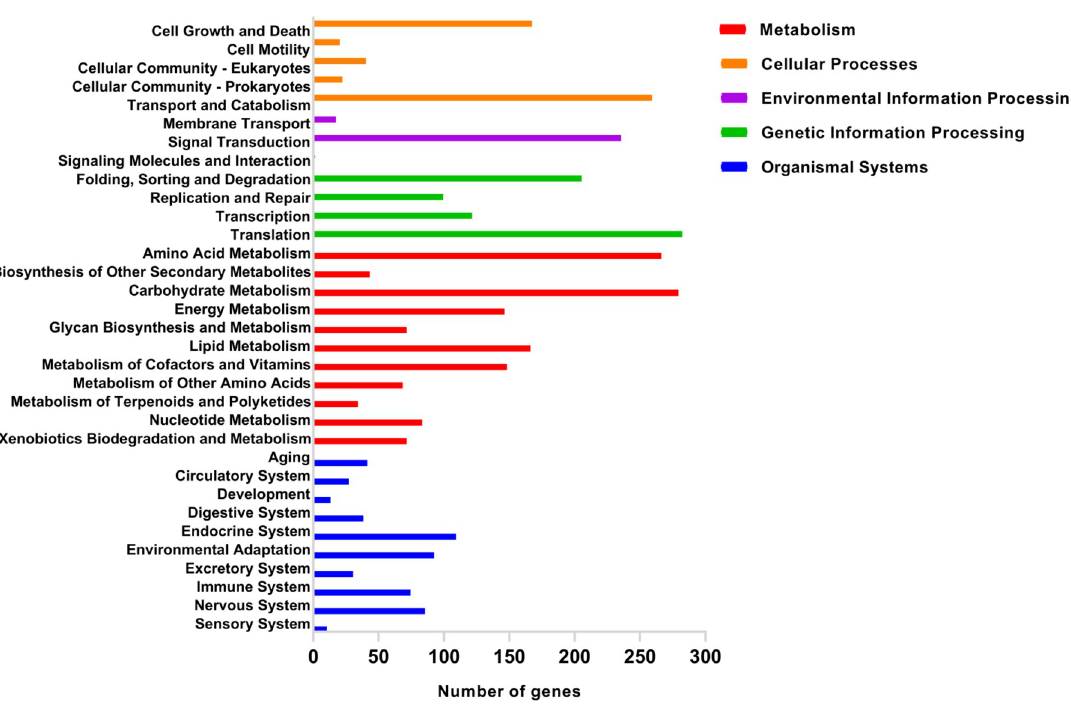
Fig 1. Enrichment analysis of KEGG pathways for predicted genes of the M . purpureus CSU-M183 genome. The y-axis represents the KEGG pathway and the x-axis denotes the number of genes.